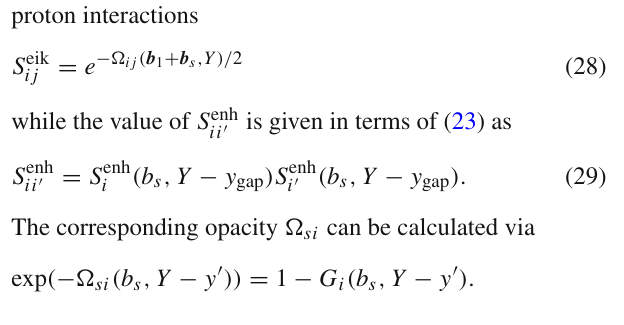
Next, the slope of diffractive dissociation B dis ( t = 0 )